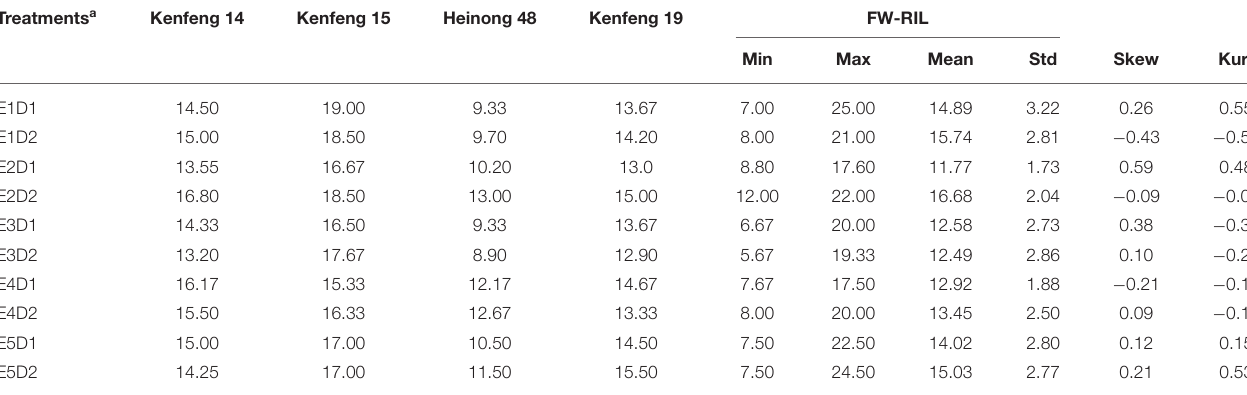
TABLE 1 | Summarization of phenotype of nod number in main stem. Treatments